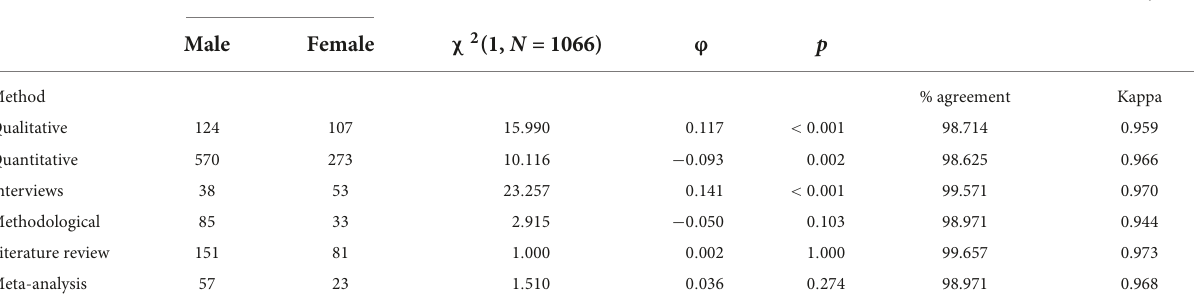
TABLE 1 Number of papers with male and female lead authors across